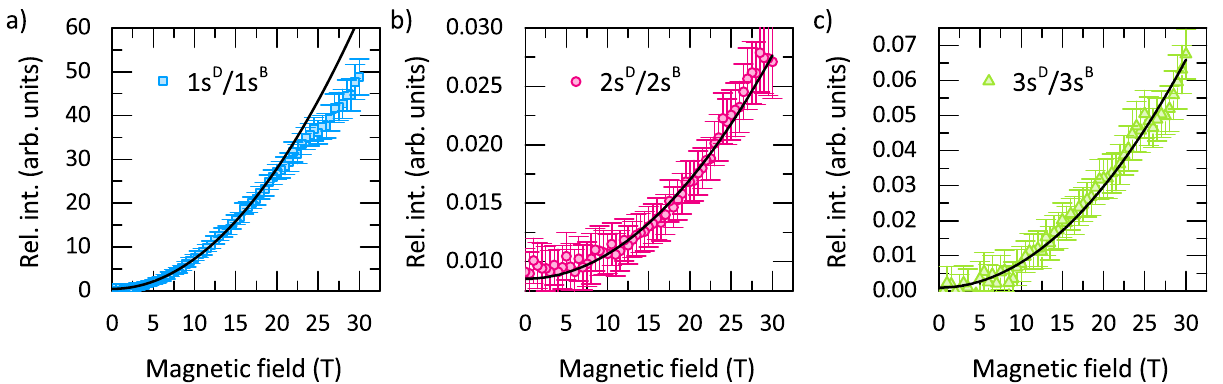
Fig. 3 Brightening of the dark-exciton Rydberg states. Intensities of dark states relative to the intensity of bright states (Rel. int. = I D ð n Þ = I B n ð Þ ) as a function of the in-plane magnetic fi eld for a the 1s states (blue squares), b the 2s states (red circles), and c the 3s states (green triangles) along with quadratic fi ts (black lines) of the form a þ bx 2 . Note that in the case of 1s states, only datapoints from 0 T to 20 T were considered for the fi tting, as for higher fi elds, the relative intensity clearly starts to deviate from quadratic dependence. The error bars represent combined standard uncertainties resulting from the uncertainties of the estimation of the photoluminescence intensities of bright and dark-exciton states. More details on this estimation can be found in Supplementary Note 1.